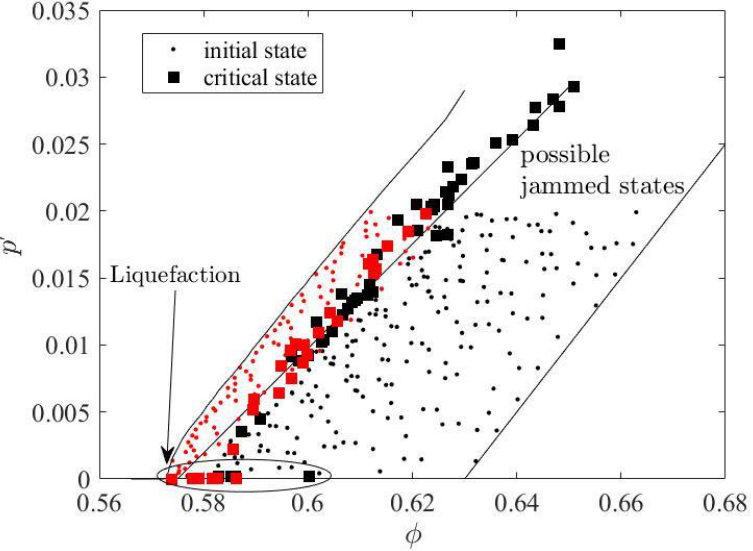
Figure 6. Critical state density and pressure.